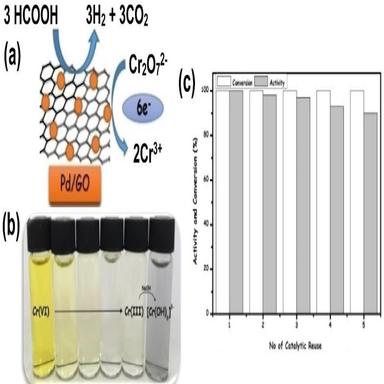
Schematic illustration for the preparation of Pt@Pd NCs/N-rGO and the catalytic reduction mechanism of Cr(VI) on Pt@Pd NCs/N-rGO.